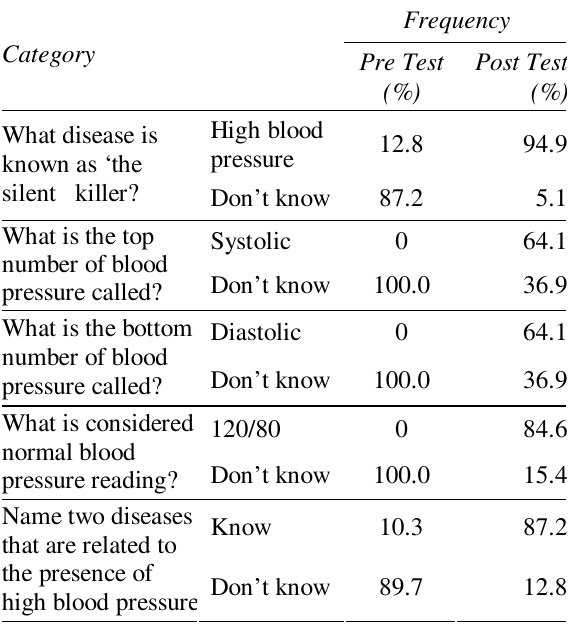
Table 1: Students’ pre-test and post-test responses